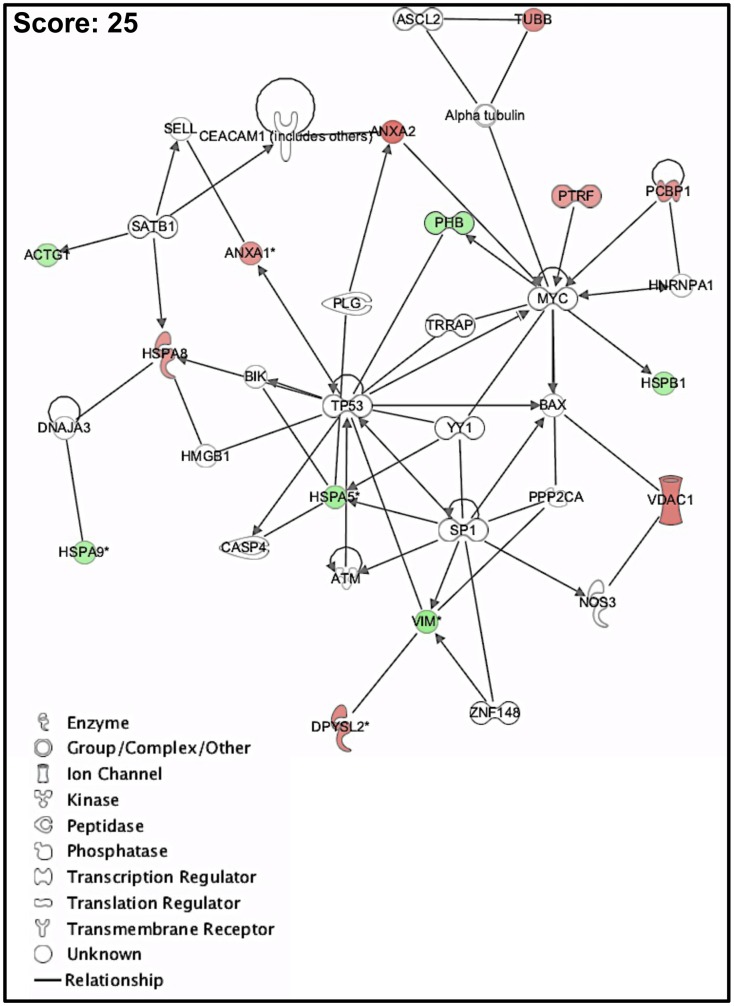
Biological network over-represented in P3 and P7 proteomes.Over-represented biological network identified by the IPA software (www.ingenuity.com). Proteins identified in the dataset are highlighted in red or in green when they exhibit a higher or a lower content in P7 compared to P3. Color intensity is directly related with protein fold change. When several protein isoforms are present, the isoform exhibiting the higher value of fold change is selected.